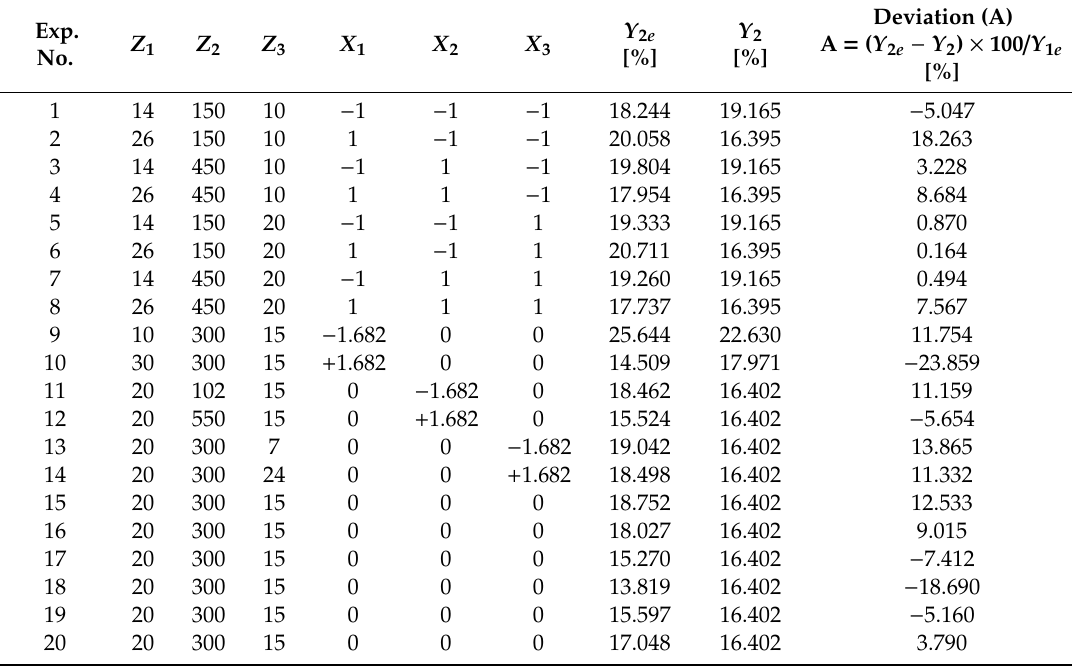
Table 5. Experimental planning matrix for Y 2 (discoloration